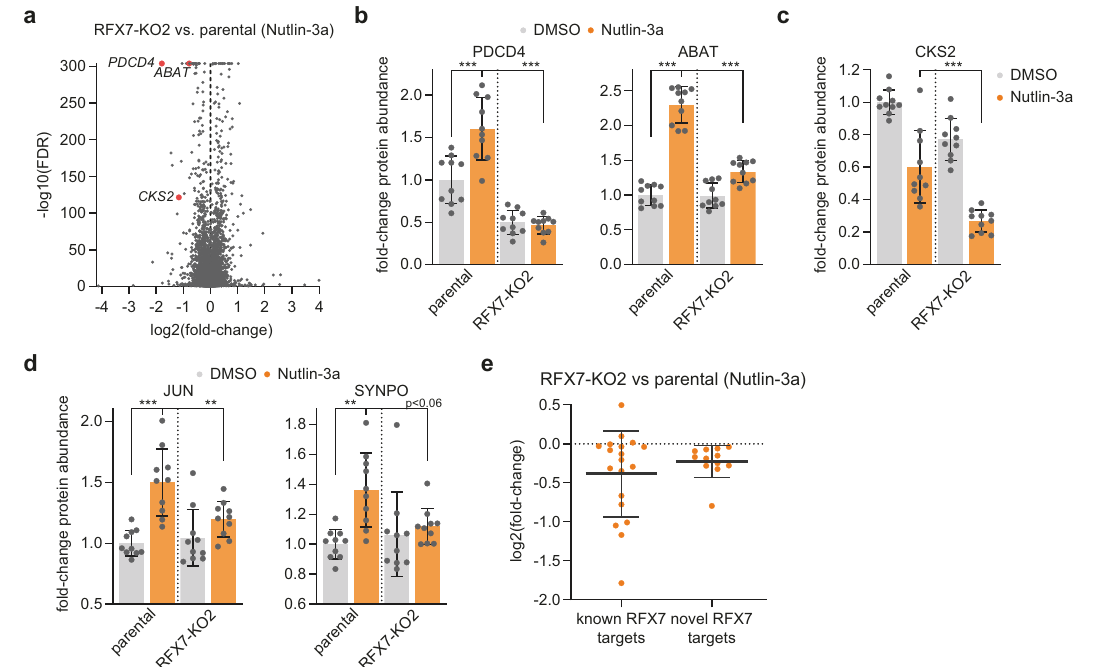
Fig. 4 Proteome data validates RFX7 targets. a Volcano plot of differential protein expression data from RFX7 knock-out clone 2 compared to parental U2OS cells under Nutlin-3a treatment condition. Data have been obtained using Spectronaut and are available in Supplementary Table S2. Selected known RFX7 targets are highlighted. b – d Fold-change expression values of protein abundance. Normalized to DMSO- treated parental U2OS cells. Statistical signi fi cance obtained through a one-way ANOVA test, n = 10 biological replicates. b The established RFX7 targets PDCD4 (left) and ABAT (right). c The established RFX7 target, cell cycle gene, and DREAM target CKS2. d The novel RFX7 targets JUN (left) and SYNPO (right). e Log 2 (fold-change) values for 19 out of 57 established RFX7 targets [23] and 11 out of 33 novel RFX7 targets (Fig. 3a) from mass spectrometry analyses of RFX7 knock-out U2OS cells compared with parental U2OS cells under Nutlin-3a treatment condition. Mean and standard deviation is displayed.